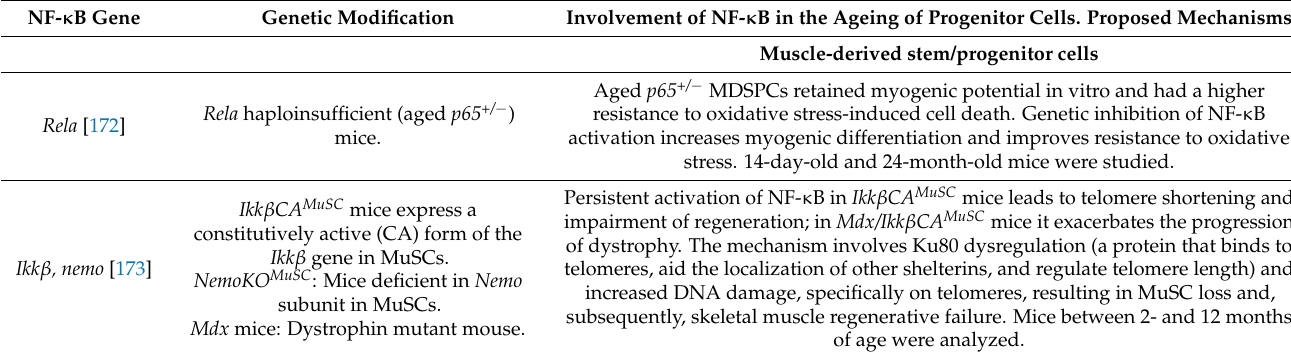
Table 5. Improvement of the decline of stem cell functions in ageing individuals by NF- κ B blockade. NF- κ B